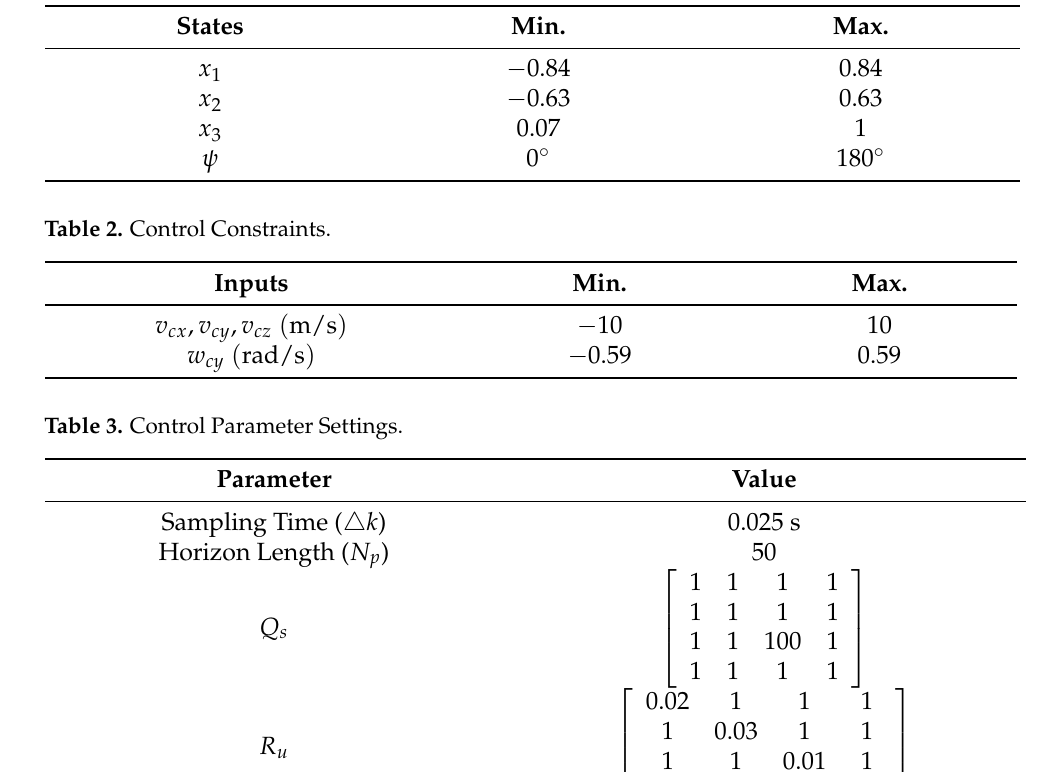
Table 1. State Constraints.